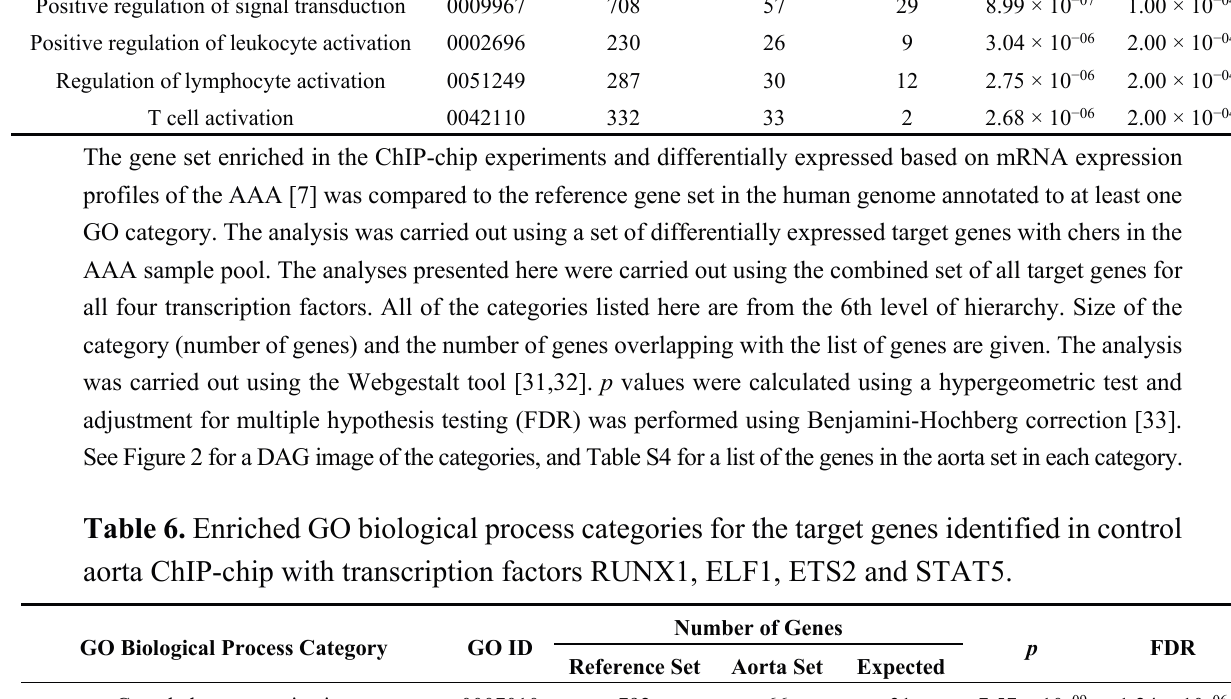
Table 6. Enriched GO biological process categories for the target genes identified in control aorta ChIP-chip with transcription factors RUNX1, ELF1, ETS2 and STAT5. GO Biological Process Category GO ID Small GTPase mediated signal transduction Regulation of cell